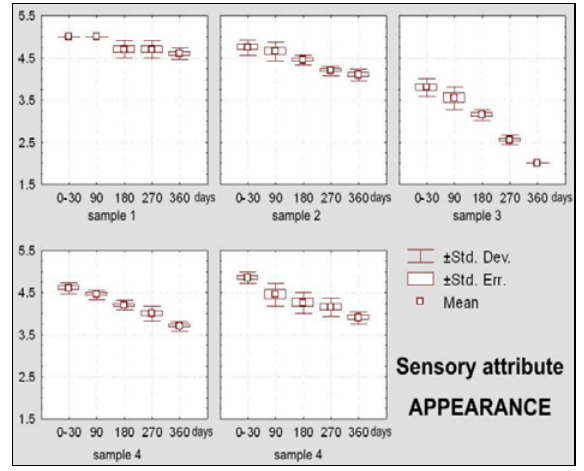
Figure 11. Box-plots for sensory attribute appearance of dietary